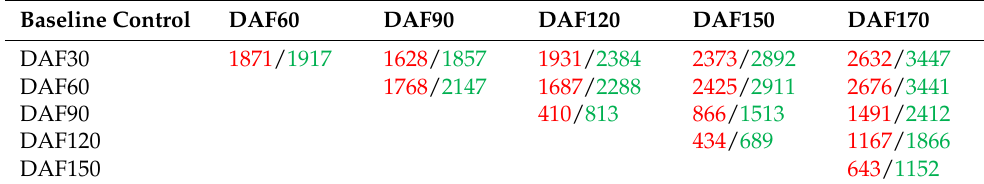
Table 1. Differentially expressed genes identified in the comparative Illumina transcriptome analysis.